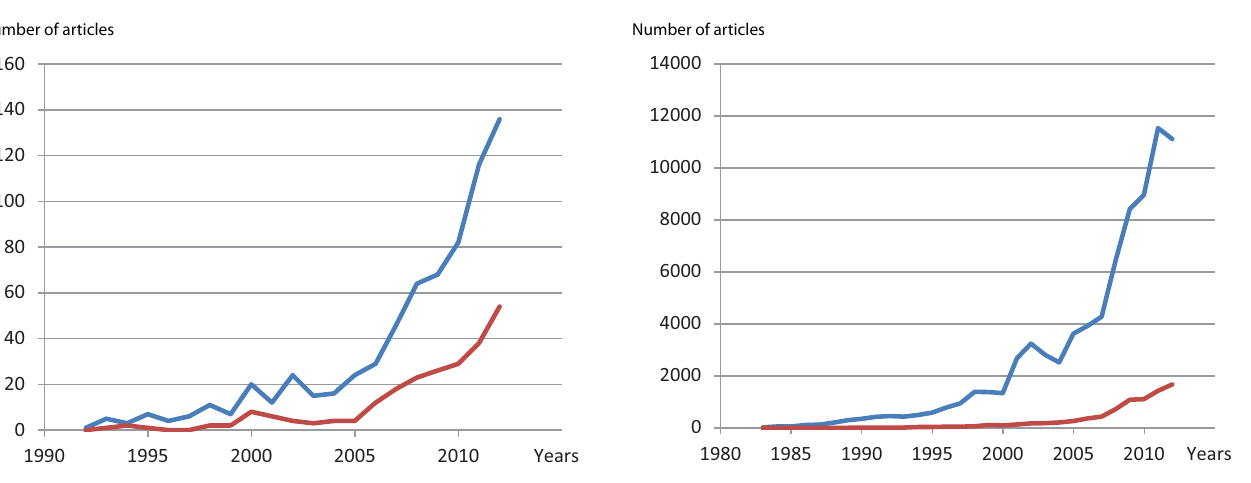
Fig. 1. Data from the Web of Science. Fig. 2. Data from the Factiva